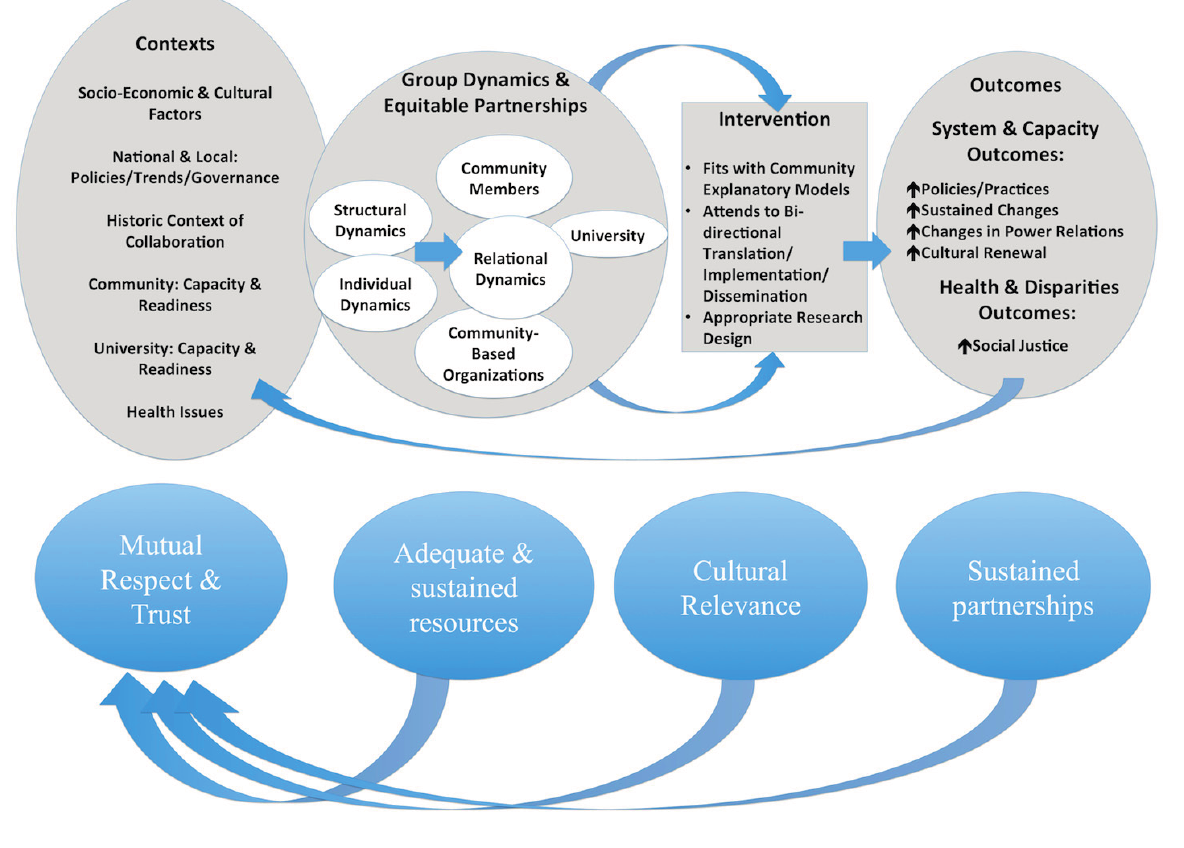
Figure 1. Case study conceptual CBPR model as an example (Figure redrawn and adapted from [31], with